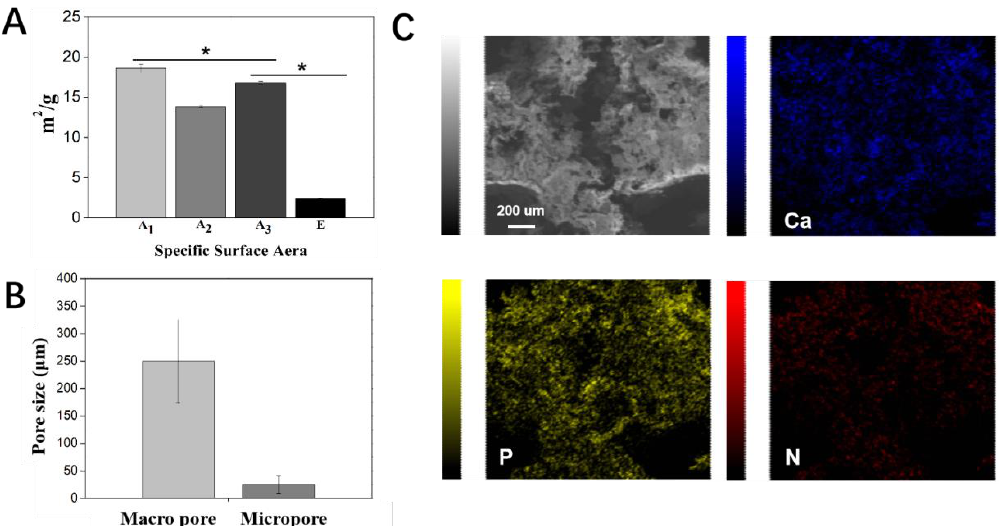
Figure 4. Physical characterization of scaffolds. ( A ) Specific surface area of Group A 1 , A 2 , and A 3 and E. ( B ) Pore size of the macroscopic pore and micropore on struts in Group E. ( C ) EDS-X elemental mapping of Ca, P, and N on scaffolds in Group E-TCH 1 . * p < 0.05.